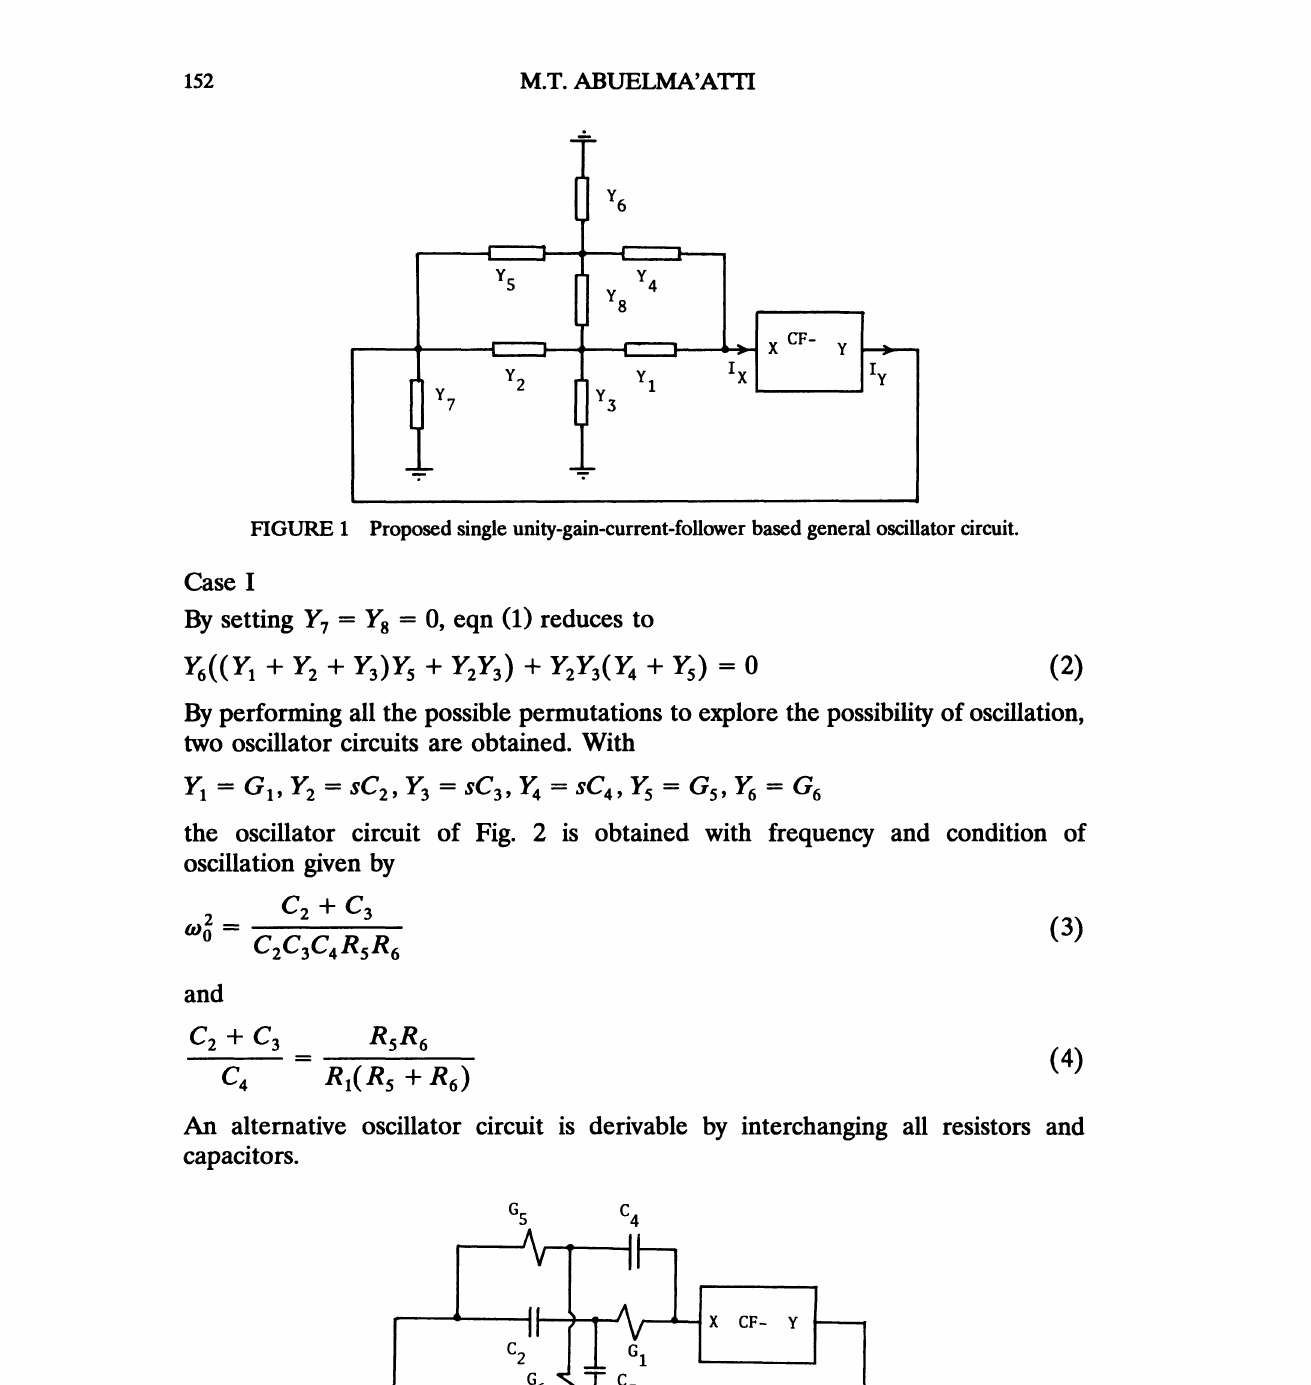
FIGURE 2 A proposed unity-gain-current-follower based oscillator circuit derived from Fig.